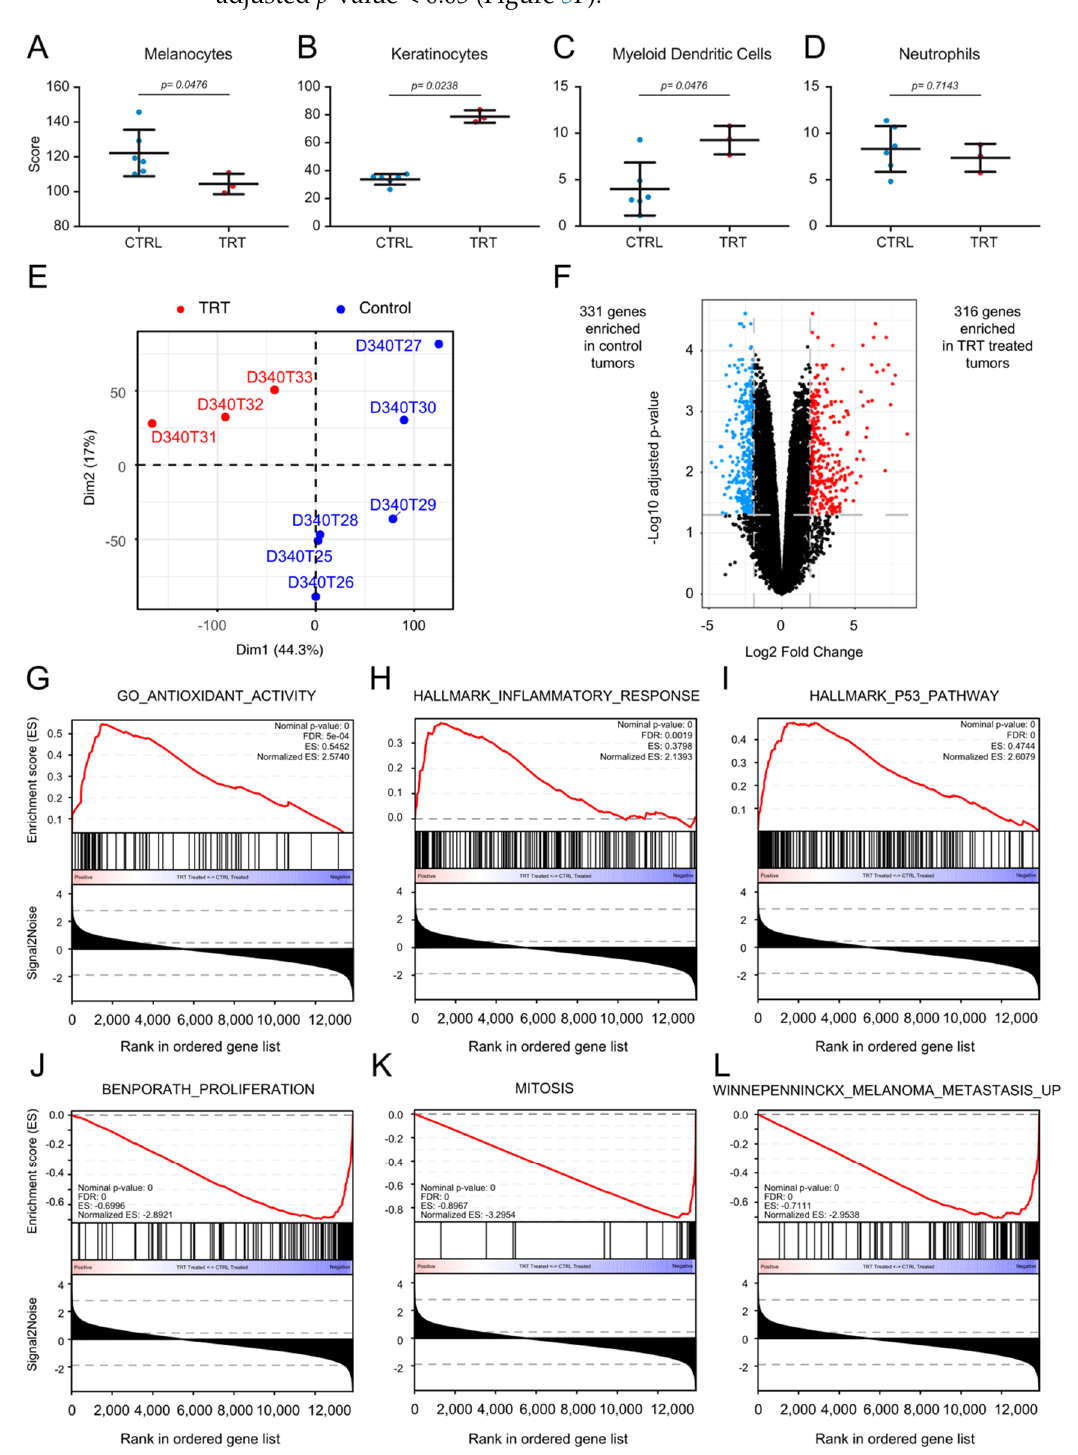
Figure 5. Bioinformatics analysis of treated and non-treated tumors. ( A – D ) Deconvolution results comparing the enrichment of various cell populations between six control-treated tumors and three TRT-treated tumors. Results for the three significantly enriched cell populations: melanocytes ( A ), keratinocytes ( B ), and myeloid dendritic cells ( C ) and one of the non-modified populations, (neutrophils) ( D ) , are depicted. ( E ) Principal component analysis (PCA) showing a clear demarcation between TRT-treated tumors and mock-treated tumors. ( F ) Volcano-plot depicting the differential analysis results between TRT-treated tumors and control tumors. Differentially expressed genes were defined as genes with an adjusted p -value < 0.05 and a fold-change > 2 SD of the fold change (https://www.ncbi.nlm.nih.gov/geo/query/acc.cgi?acc=GSE162536) (accessed on June 2020). In total, 316